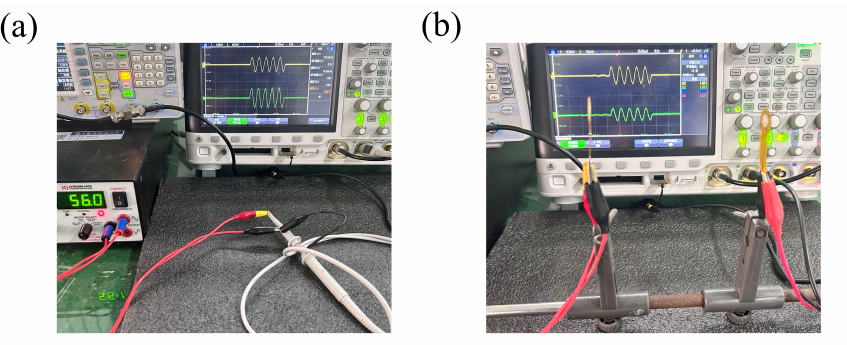
Figure 4. Test of linearity for configuration: ( a ) test of linearity for the amplified signal; ( b ) test of PZT in the air.